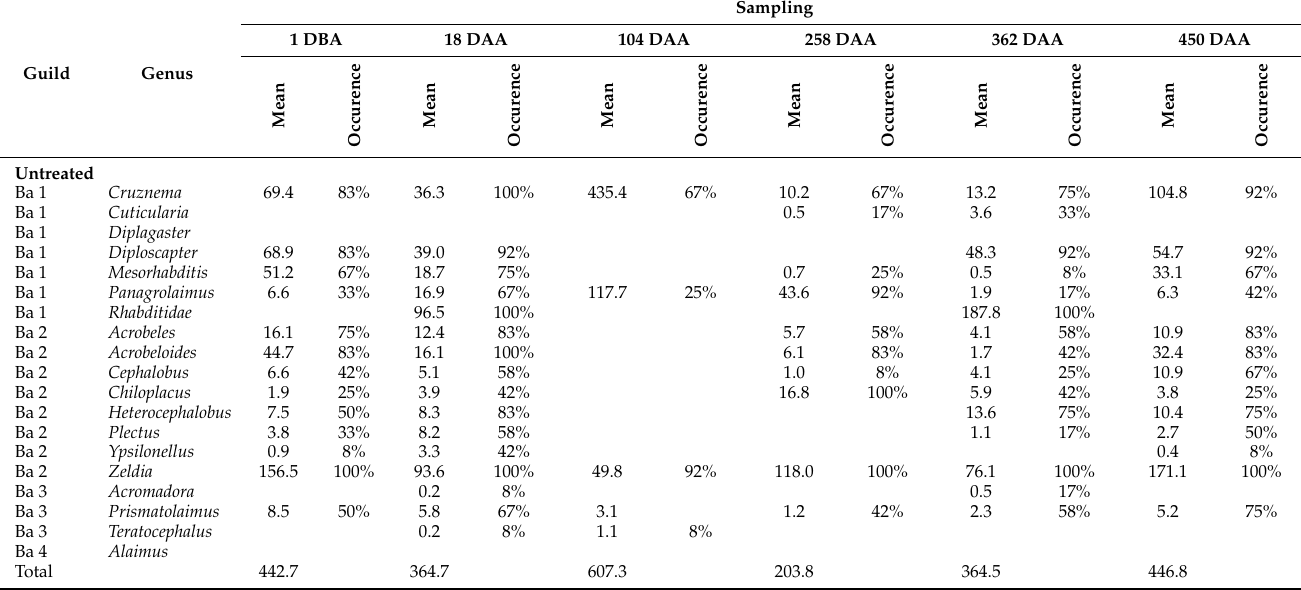
Table A2. Bacterial feeding nematodes structure. Abundance and occurrence in trial variants during the study